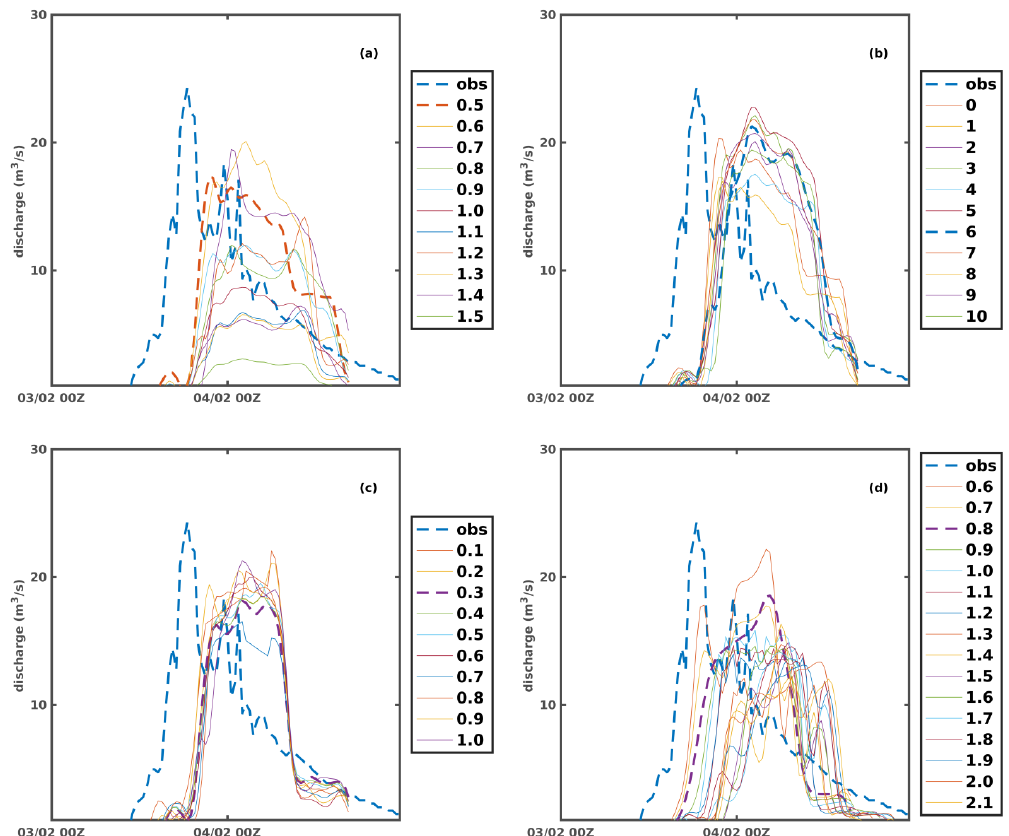
Figure 7. The evolution of the discharge (observed and simulated) for event 2 for the (a) REFKDT, (b) RETDEPRTFAC, (c) OVROUGHRTAC, and (d) MannN